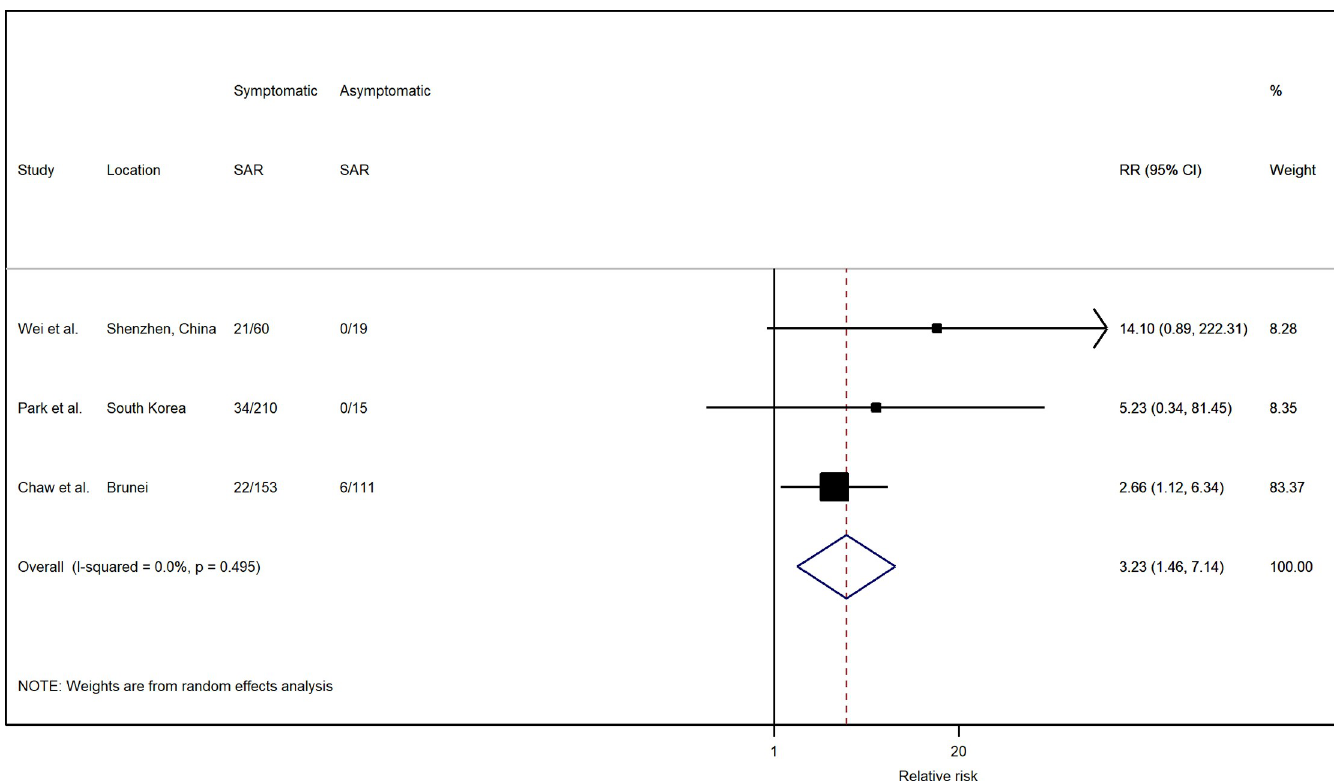
Fig 3. Forest plot of household transmission risk by symptom status of index case. RR is the estimated risk ratio, with 95% confidence intervals (CI). I-squared is the percentage of between-study heterogeneity that is attributable to variability in the true effect, rather than sampling variation.